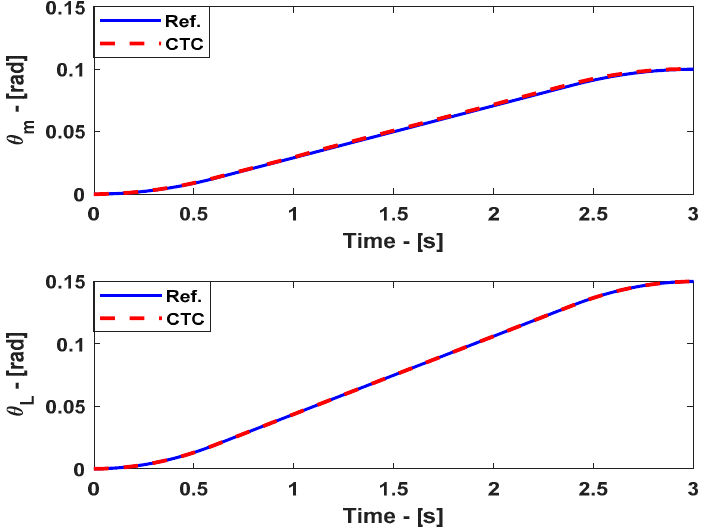
Figure 10. The responses of the BcVSA based on the CTC scheme in the scenario of altering the status of clutches while the system is running. ( Top ) the input trajectory response; ( Bottom ) the output re- sponse.